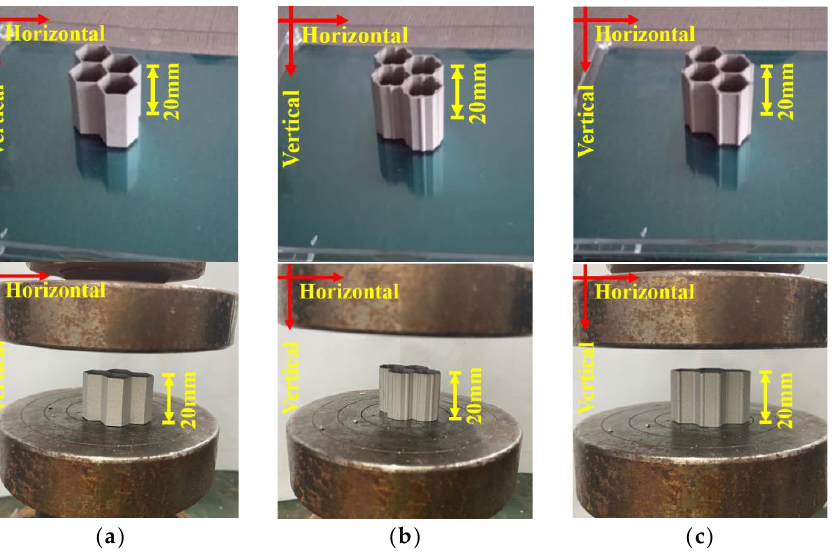
Figure 5. BHTSs out-of-plane uniaxial compression loading diagram: ( a ) BHTS – S ; ( b ) BHTS – I; ( c ) BHTS – II.